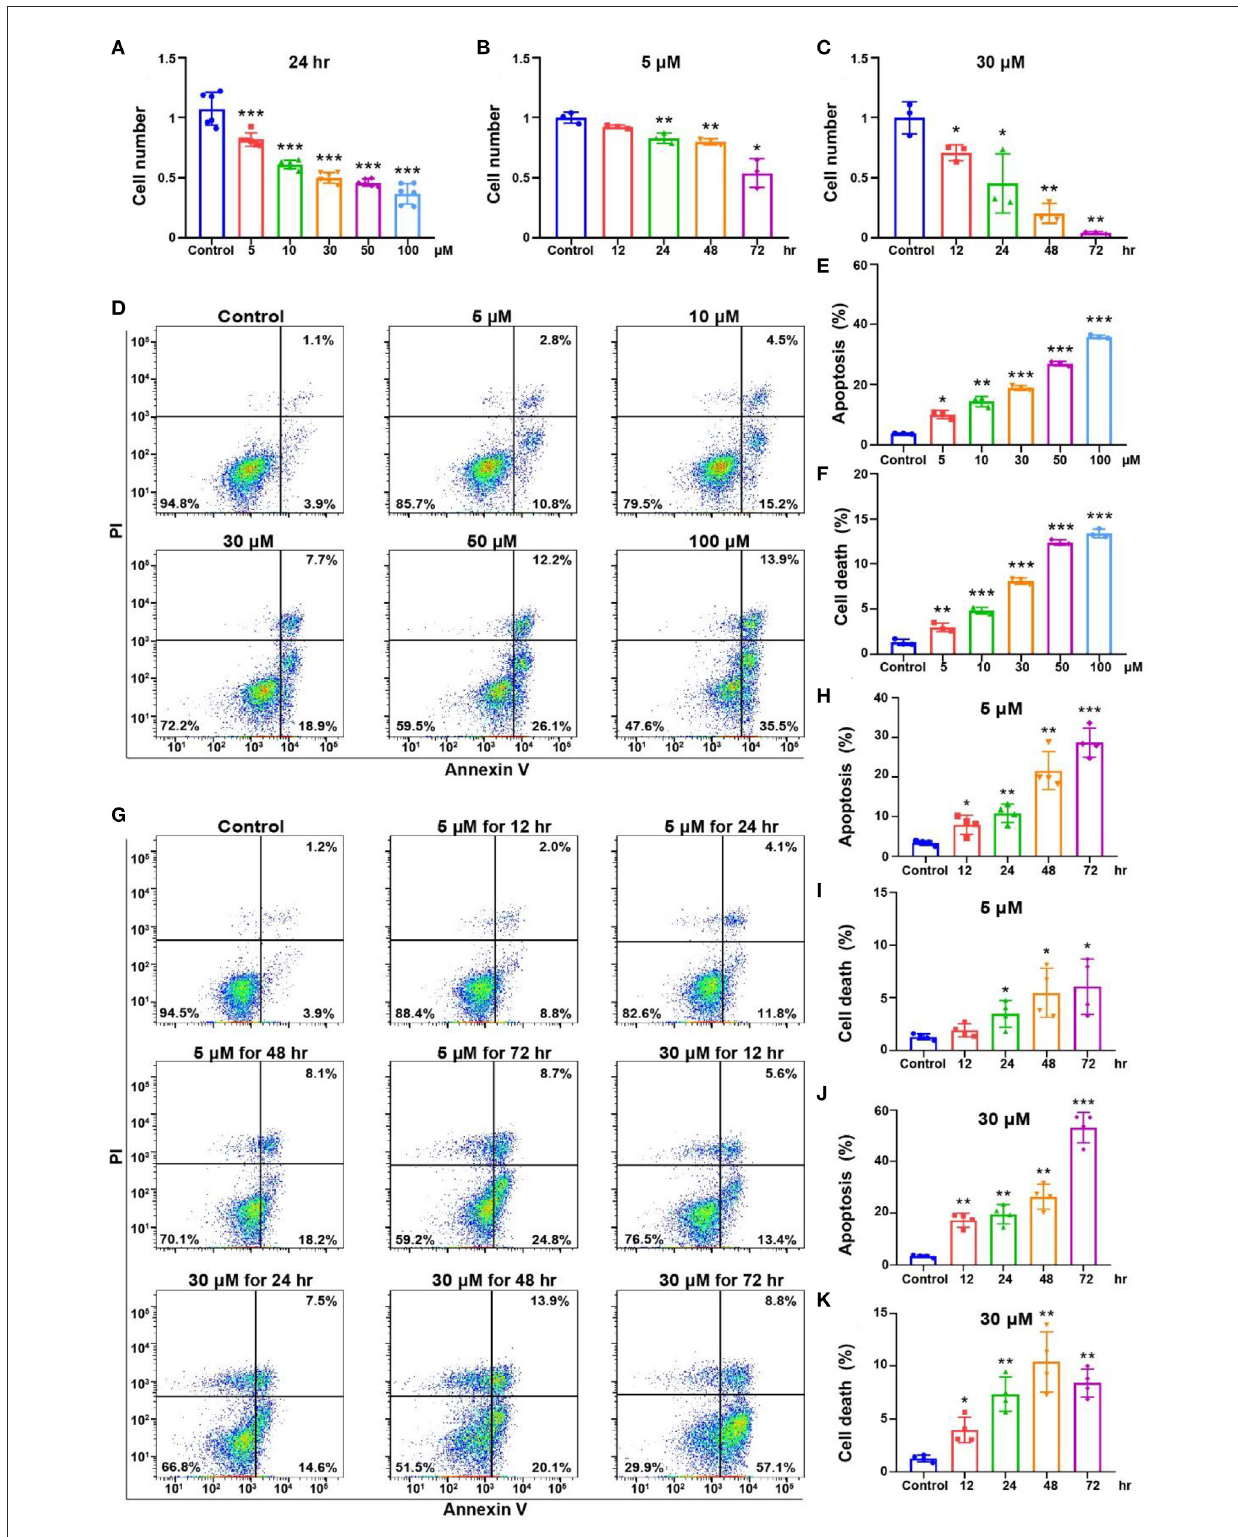
FIGURE2 Cell viability and apoptosis flow cytometry results for the OC-1 cells treated with different concentrations of cisplatin. (A) CCK-8 cell viability changes after different concentrations of cisplatin treatment for 24h. (B) CCK-8 cell viability changes after 5 µ M cisplatin treatment for different times. (C) CCK-8 cell viability changes after 30 µ M cisplatin treatment for different times. (D) Flow cytometry of apoptosis in cells treated with different cisplatin concentrations for 24h. (E) Quantification of the apoptosis ratio in (D) . (F) Quantification of the cell death ratio in (D) . (G) Flow cytometry of cells treated with 5 or 30 µ M cisplatin for different times. (H) Quantification of the apoptosis ratio in (G) . (I) Quantification of the cell death in (G) . (J) Quantification of the apoptosis ratio in (G) . (K) Quantification of the cell death ratio in (G) . * p < 0.05, ** p < 0.01, *** p <